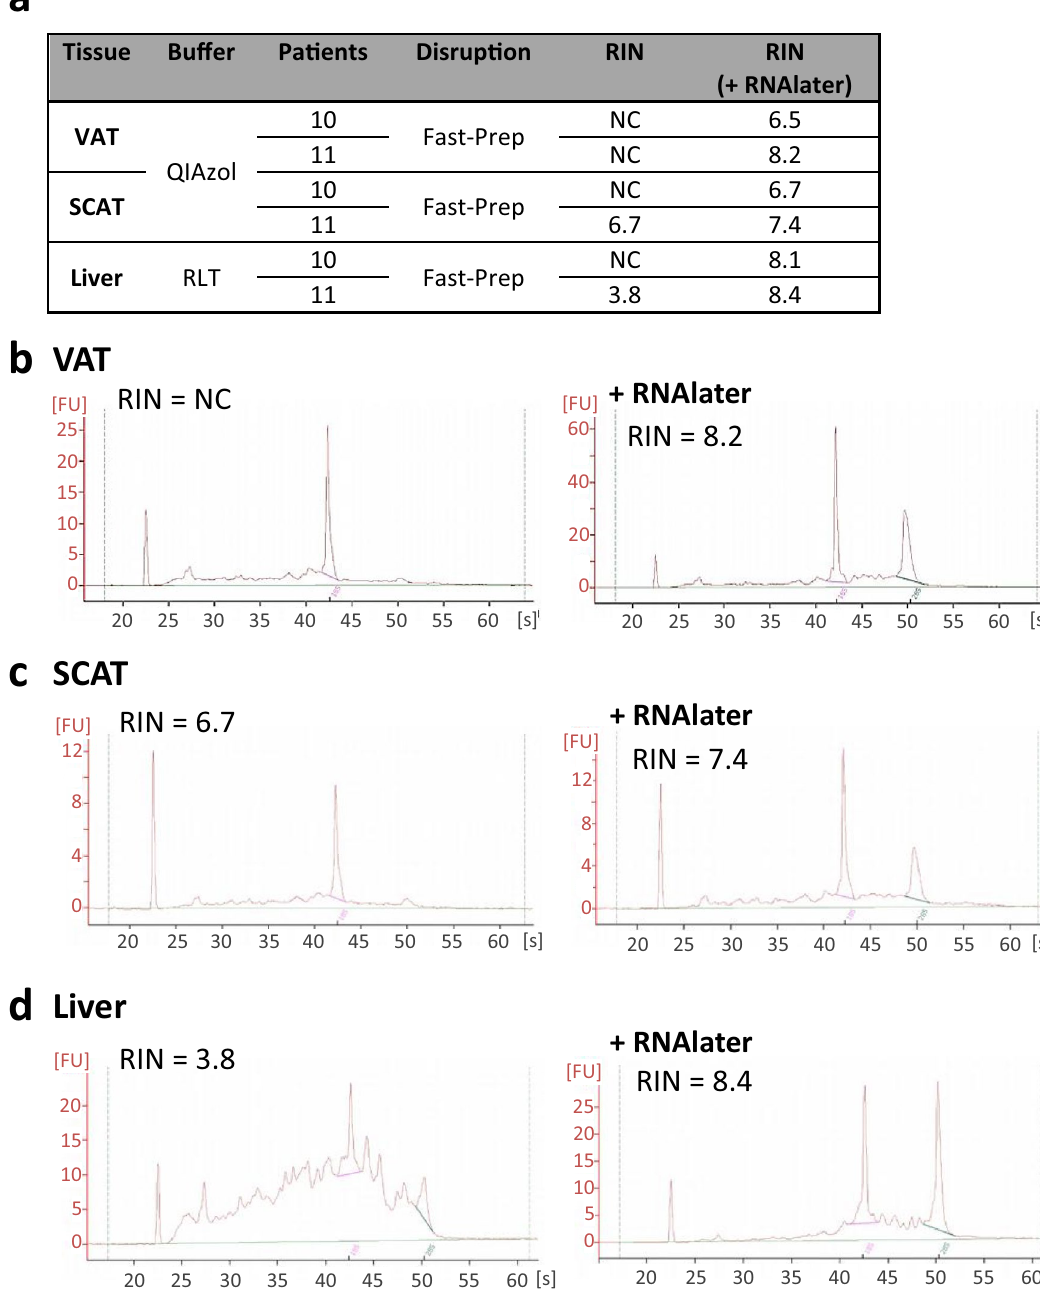
Figure 6. Impact of RNAlater pre-treatment on RNA quality of samples. ( a ) Effect of 24 h-RNAlater pre-treatment on RIN, determined using Agilent 2100 Bioanalyser and RNA 6000 Nano chips. Typical electrophoretic traces and RIN are shown for VAT ( b ), SCAT ( c ), and liver ( d ). VAT, visceral adipose tissue, SCAT, sub-cutaneous adipose tissue. FastPrep for FastPrep-24 Instrument. NC